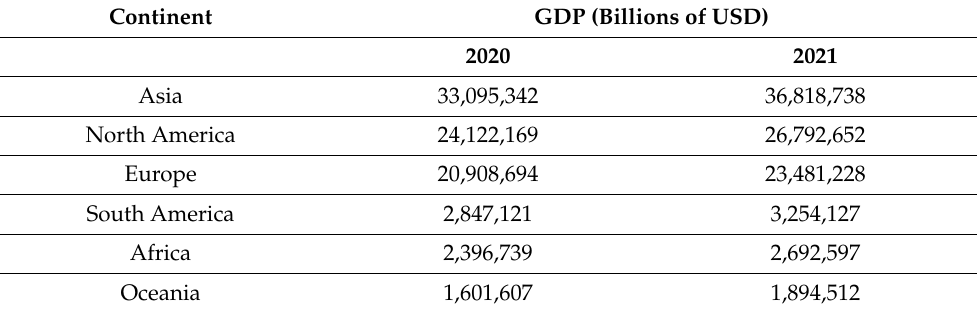
Table 2. GDP by continents in 2020 and